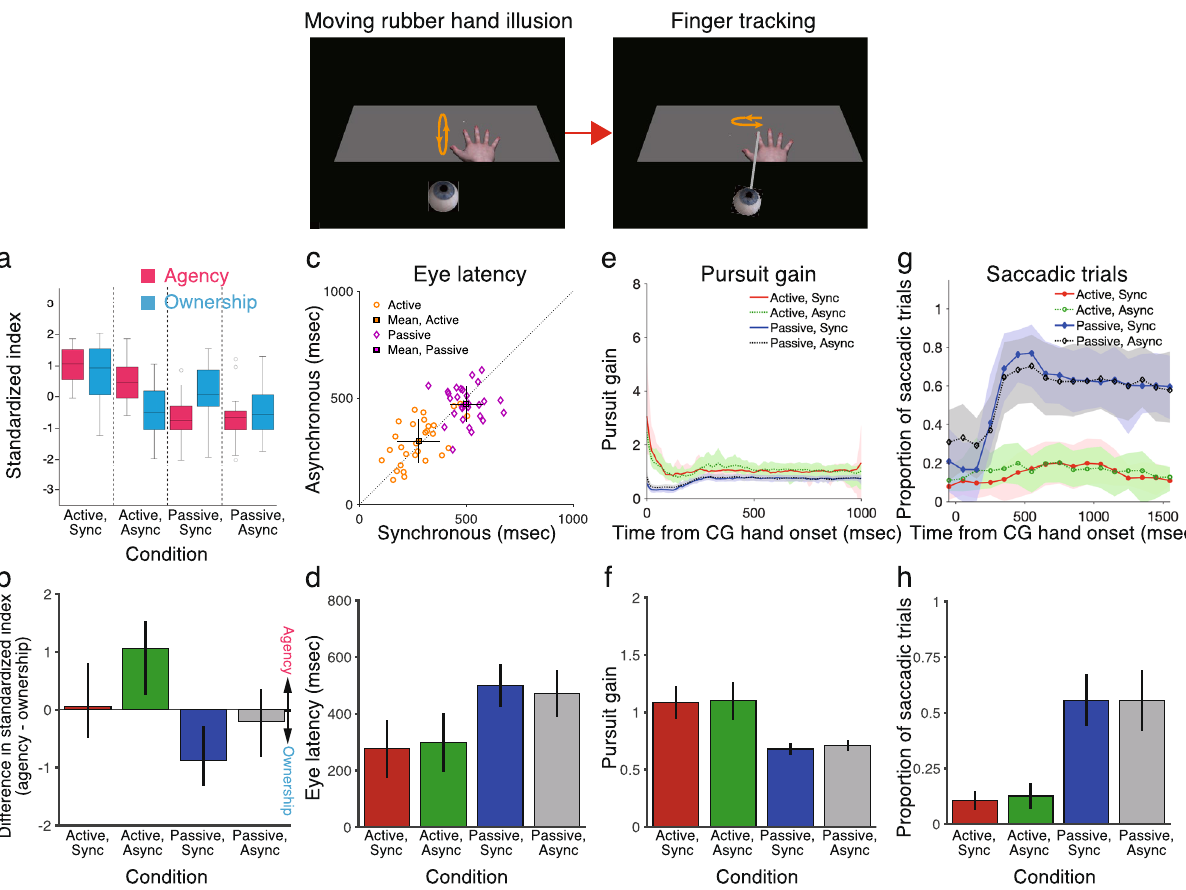
Figure 4. Results of experiment 2. ( a , b ) Strength of the rated ownership and agency of the computer graphics (CG) hand shown as box-and-whisker plots for the four conditions. The ownership and agency indexes were defined as the difference in ratings between the illusion and control questions. ( a ) The standard score (z-score) was calculated for each of the ownership (blue) and agency (pink) indexes, which were defined as the standardized index. Horizontal black bars represent medians, and the boxes denote the interquartile ranges. Whiskers extend to the farthest data points within 1.5 times the interquartile range from the top and bottom edges of the boxes. Individual open circles represent outliers. ( b ) The standardized ownership index was subtracted from the standardized agency index. Colored bars represent the medians, and the error bars represent the interquartile ranges. ( c , d ) Eye latency, as defined by eye onset time relative to CG hand onset time. Orange and purple symbols represent the active and passive hand movement conditions, respectively, for individual participants. Square symbols represent the mean ± standard deviation. ( e , f ) Pursuit gain, defined as eye velocity divided by CG hand velocity after excluding saccades in velocity traces. ( e ) Shaded areas represent standard deviation. ( f ) Shows the average pursuit gain in the range of 0 to 1000 ms. ( g , h ) Proportion of saccadic trials in the range of − 200 to 1600 ms from CG hand onset. Results are the mean ± standard deviation in ( d – h ) ( n =